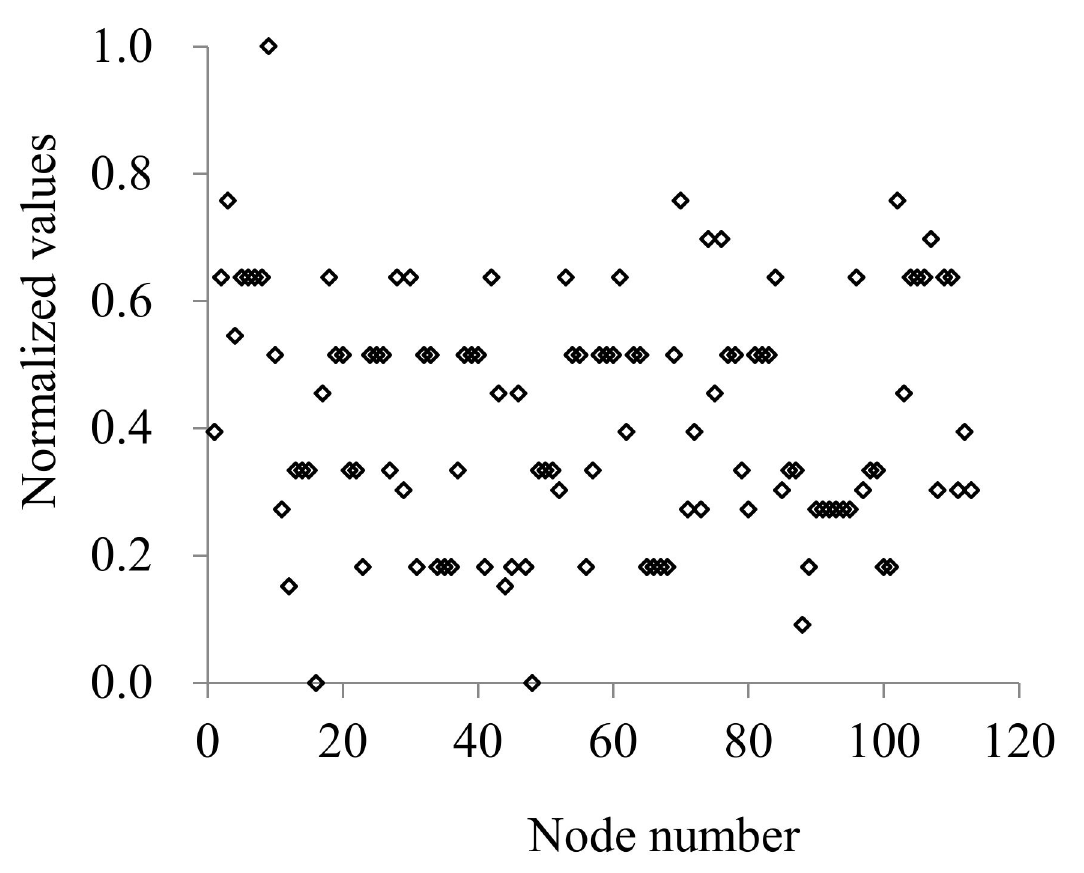
Figure 4. Normalized values of node